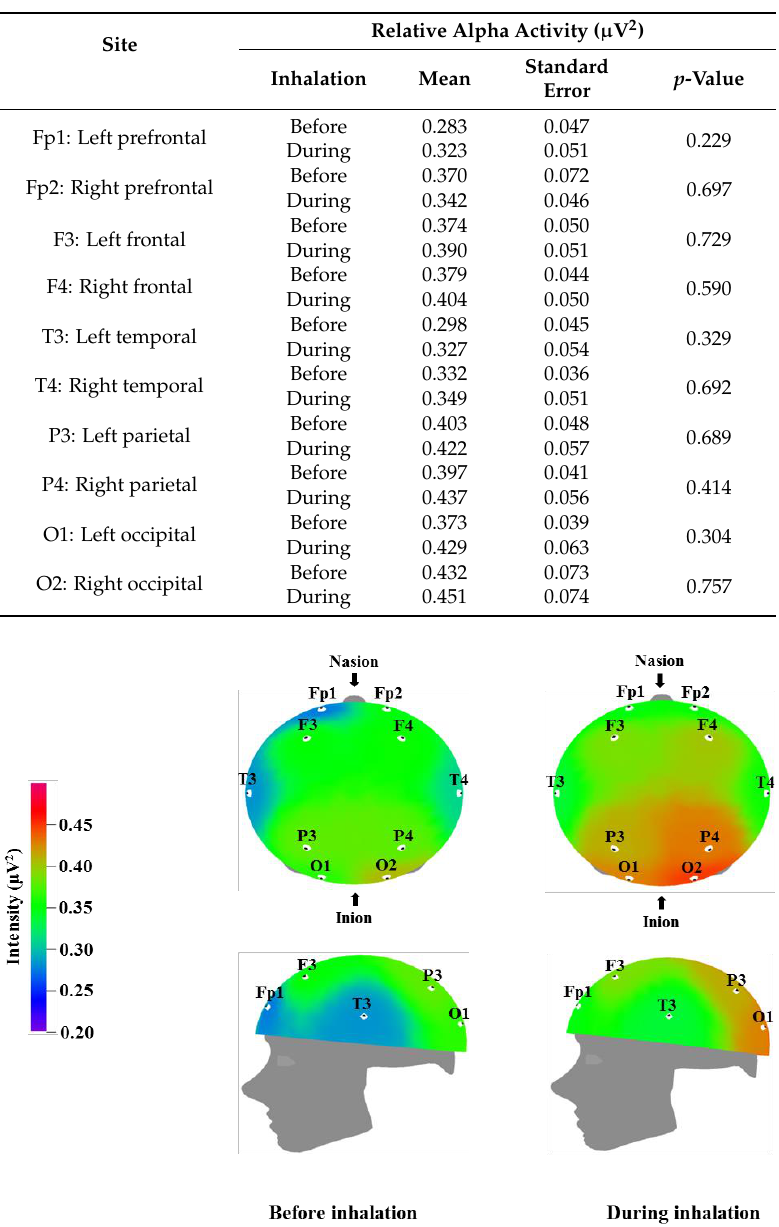
Figure 2. Relative alpha wave intensity between before and during inhalation of VOCs from C. indicum Linné.